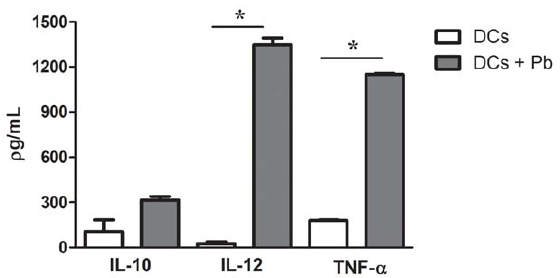
Table 3. Real-time PCR validation of microarray data.